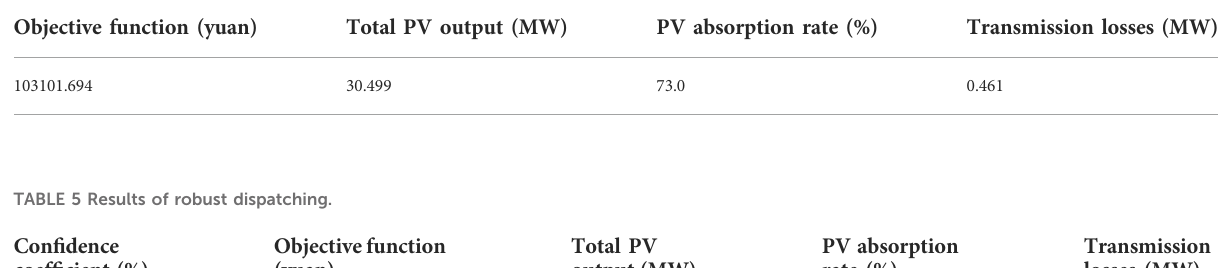
TABLE 4 Dispatching results of